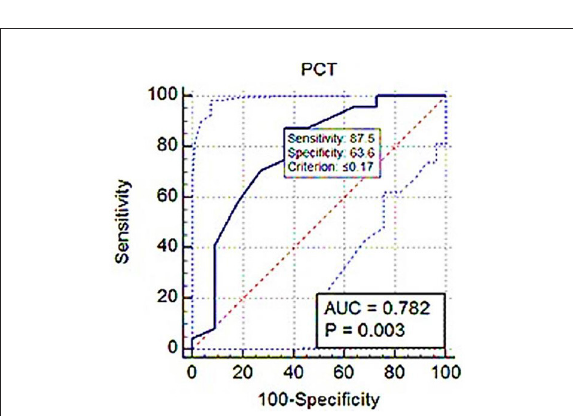
FIGURE7 ROC (receiver operating characteristic) curve analysis of PLT for S rel > 1. The solid blue line between the two blue dashed lines is the corresponding cut-off point with sensitivity and specificity. The blue dashed lines, one on the upper left side and the other on the lower right side of the solid blue line, are the upper and lower 95% confidence bounds, respectively.